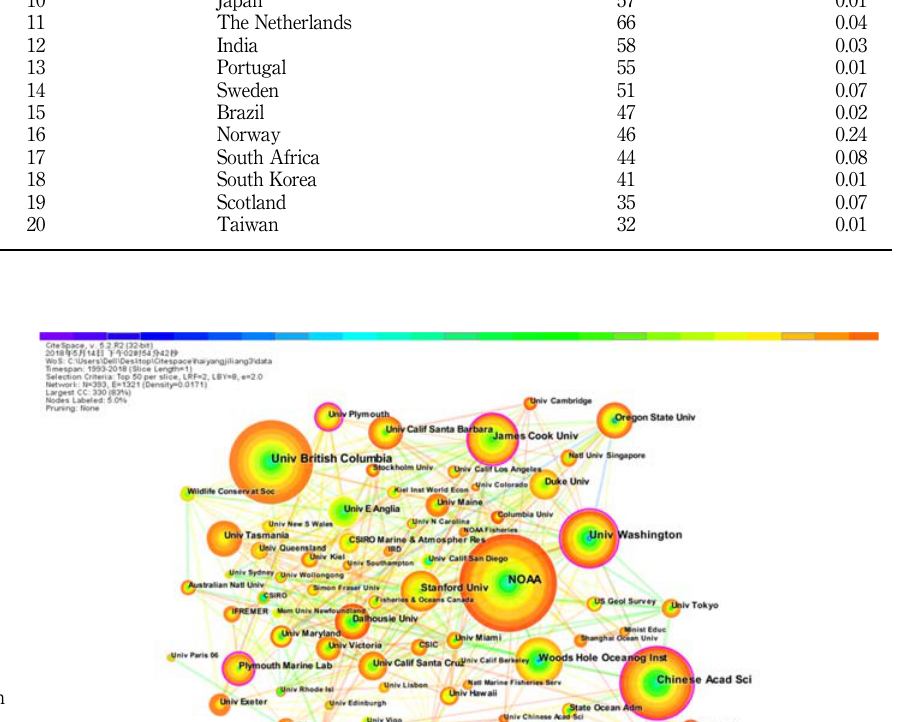
Figure 11. Cooperation network diagram of marine econometrics research